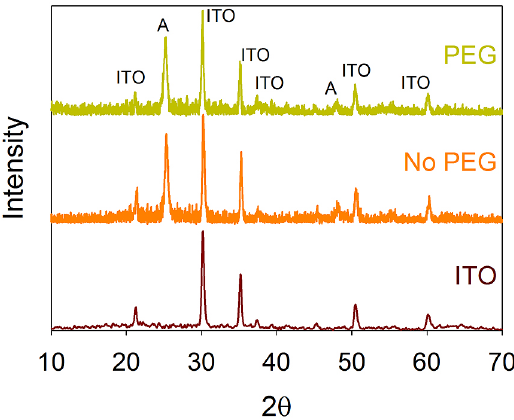
Figure 5. Diffractograms for the Substrate (ITO glass) and for the 5 layered TiO films heat treated at 500 °C. Letter A indicates the 2 peaks related to the Anatase Crystalline